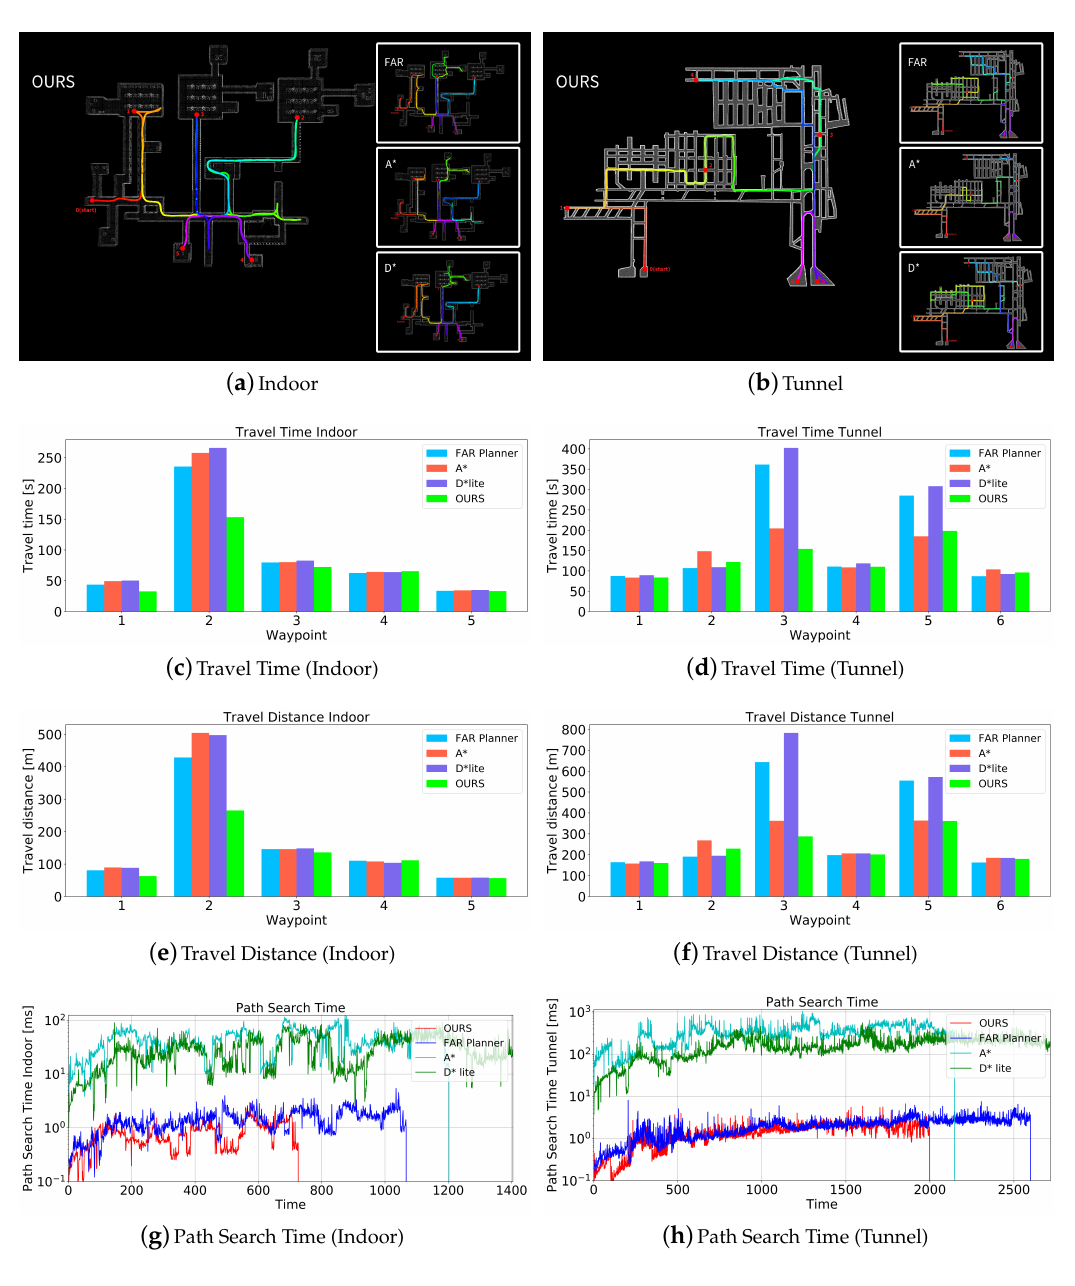
Figure 20. ( a , b ) show that the trajectory of the robot using different algorithms to navigate in indoor and tunnel simulation environments respectively and passes through a series of target points. ( c , d ) show the time consumption for each target point. ( e , f ) show the distance robot takes to travel to each target point. ( g , h ) show different path-searching algorithms’ time consumption. Figure 20c–f show the time and distance it takes for the robot to travel from